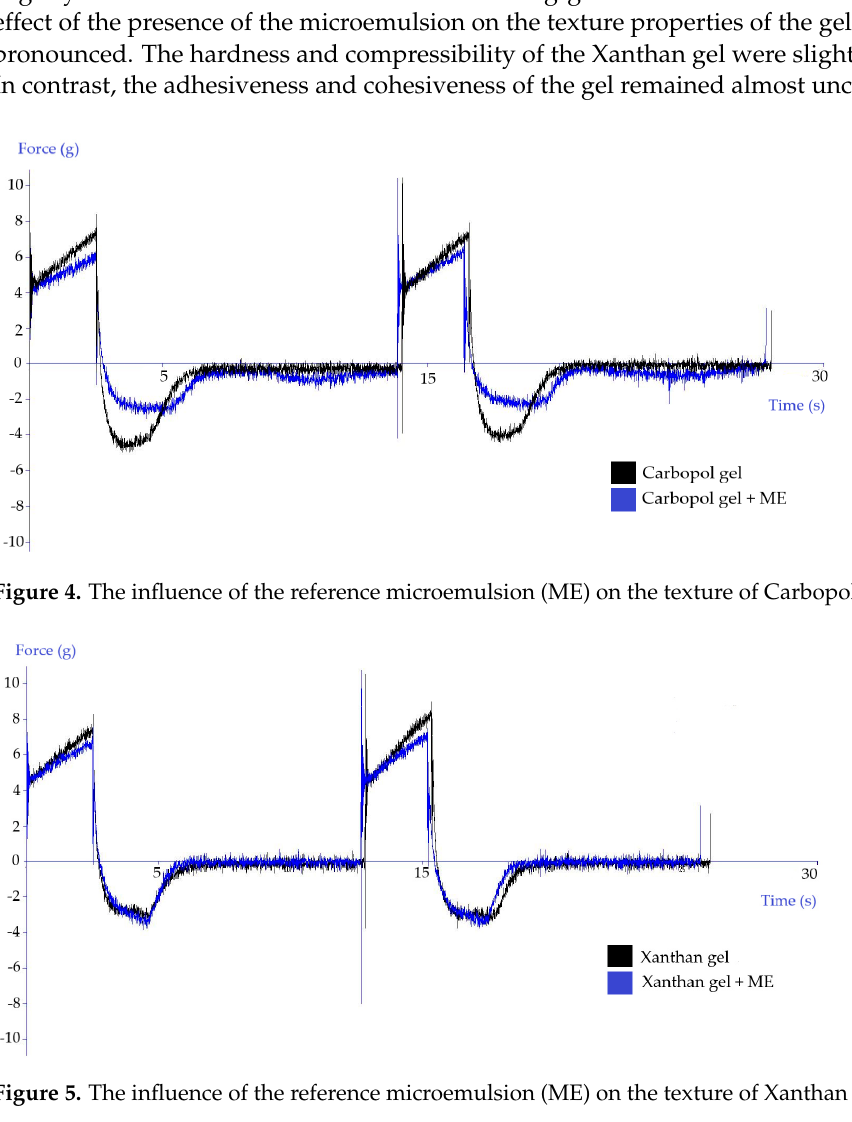
Figure 5. The influence of the reference microemulsion (ME) on the texture of Xanthan